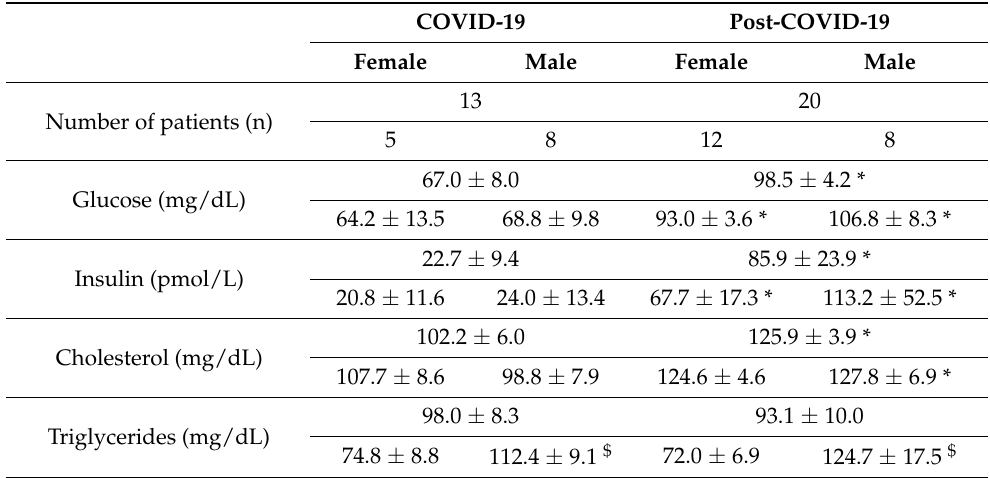
Table 1. Plasma metabolites and hormones in COVID-19 and post-COVID-19 patients. COVID-19 Post-COVID-19 Female Male Female Male 13 20 Number of patients (n) 5 8 12 8 67.0 ± Glucose (mg/dL)